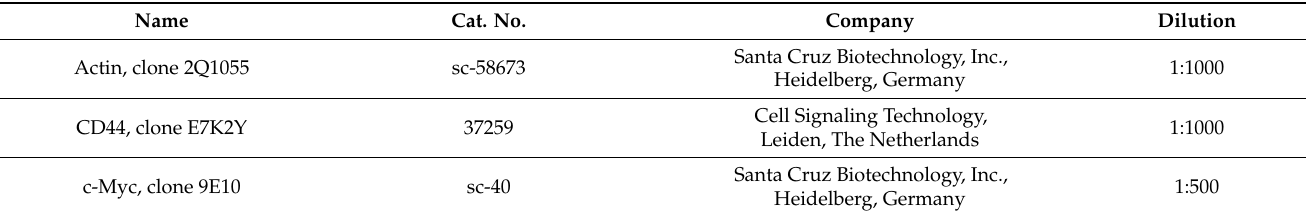
Table 1 lists antibodies used for Western Blotting. Table 1. Antibodies for Western